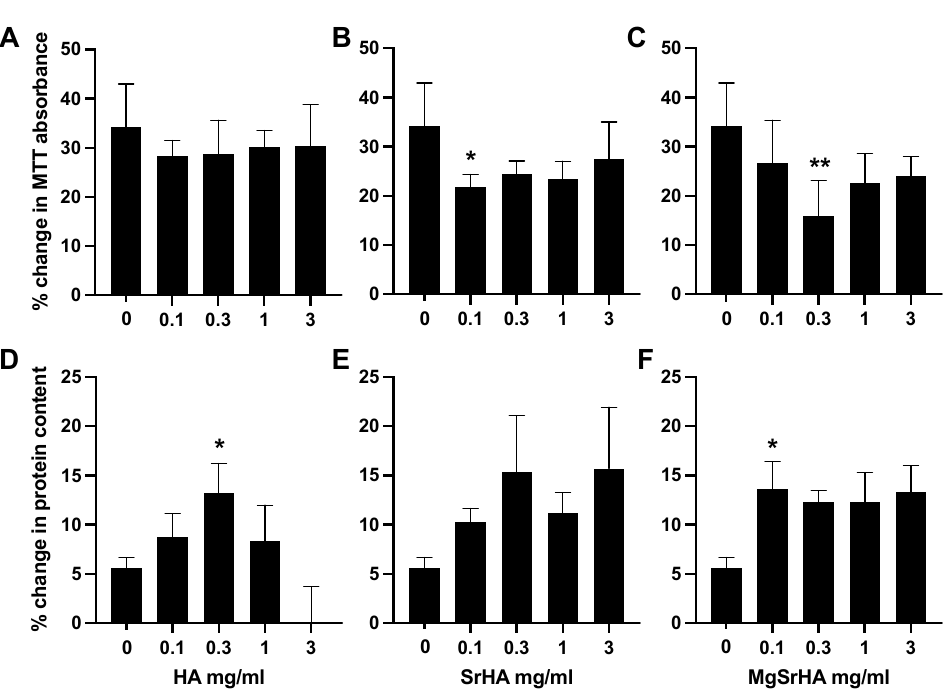
Figure 4. Primary human osteoblasts were cultured in the presence of ( A , D ) hydroxyapatite (HA), ( B , E ) Sr-substituted HA (SrHA), or ( C , F ) magnesium, strontium-substituted HA (MgSrHA) granules. Their viability was then measured using MTT assay, and their protein content was assessed with Lowry assay. Graphs ( A – C) show the difference in viability levels between day three and day seven, expressed as percent change from day three. Graphs ( D – F ) show the difference in protein levels between day three and day seven, expressed as percent change from day three. * = p < 0.05 and ** = p < 0.01 vs control.